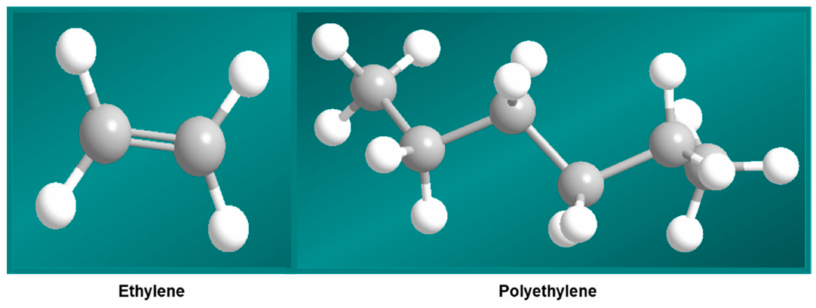
Figure 1. The 3D structures of ethylene and